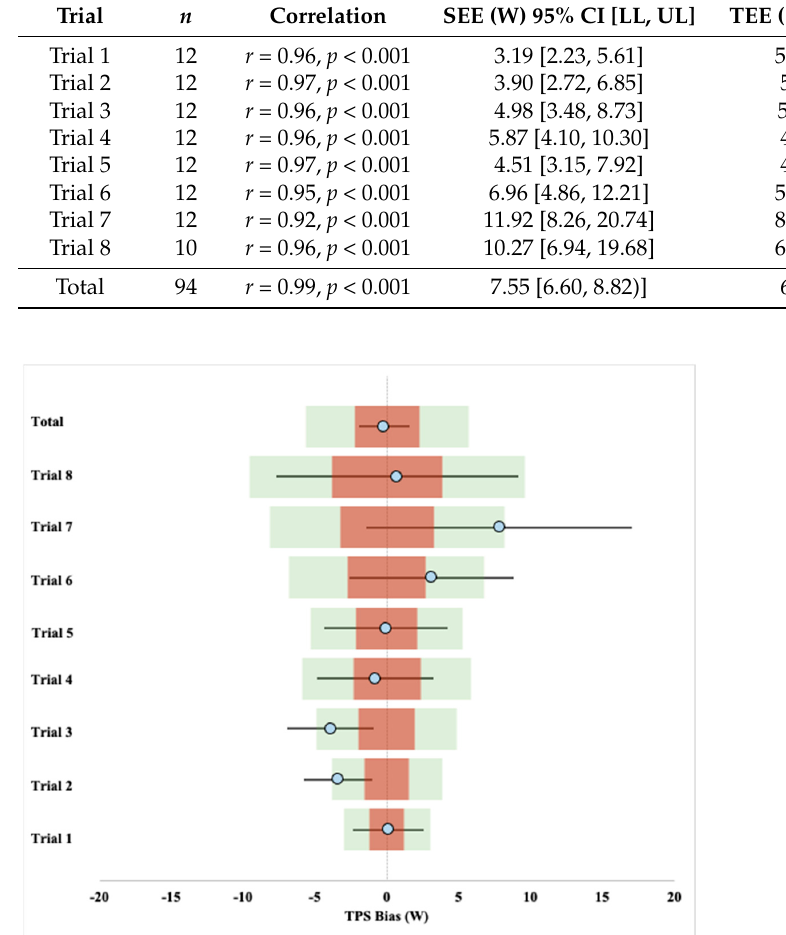
Sensors 2021 , 21 , 6117 Figure 4. Bias with 95% confidence limits per trial compared with ± 2% and 5% of the SRM mean.